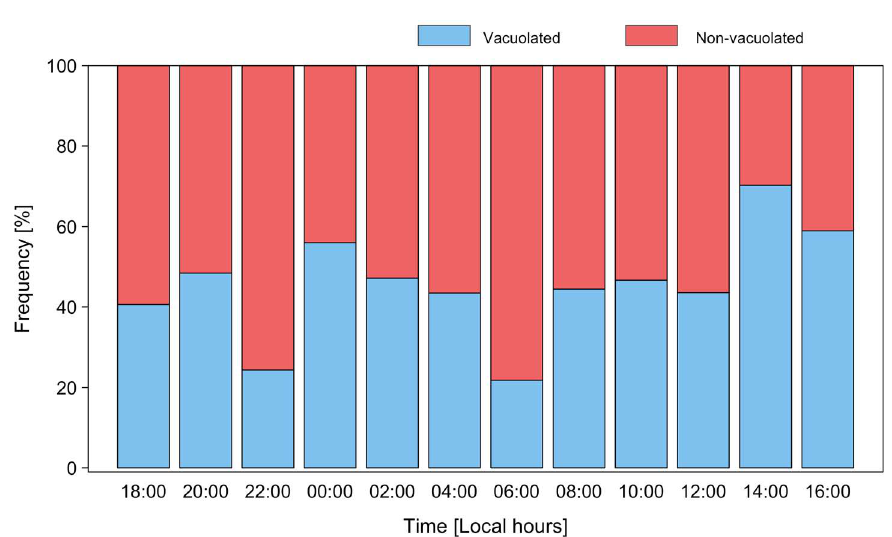
Figure 6. Distribution of frequencies of vacuolated (blue) and non-vacuolated (red bars) cells of P. rotundatum during a 24 h cycle from 16 to 17 January 2018.